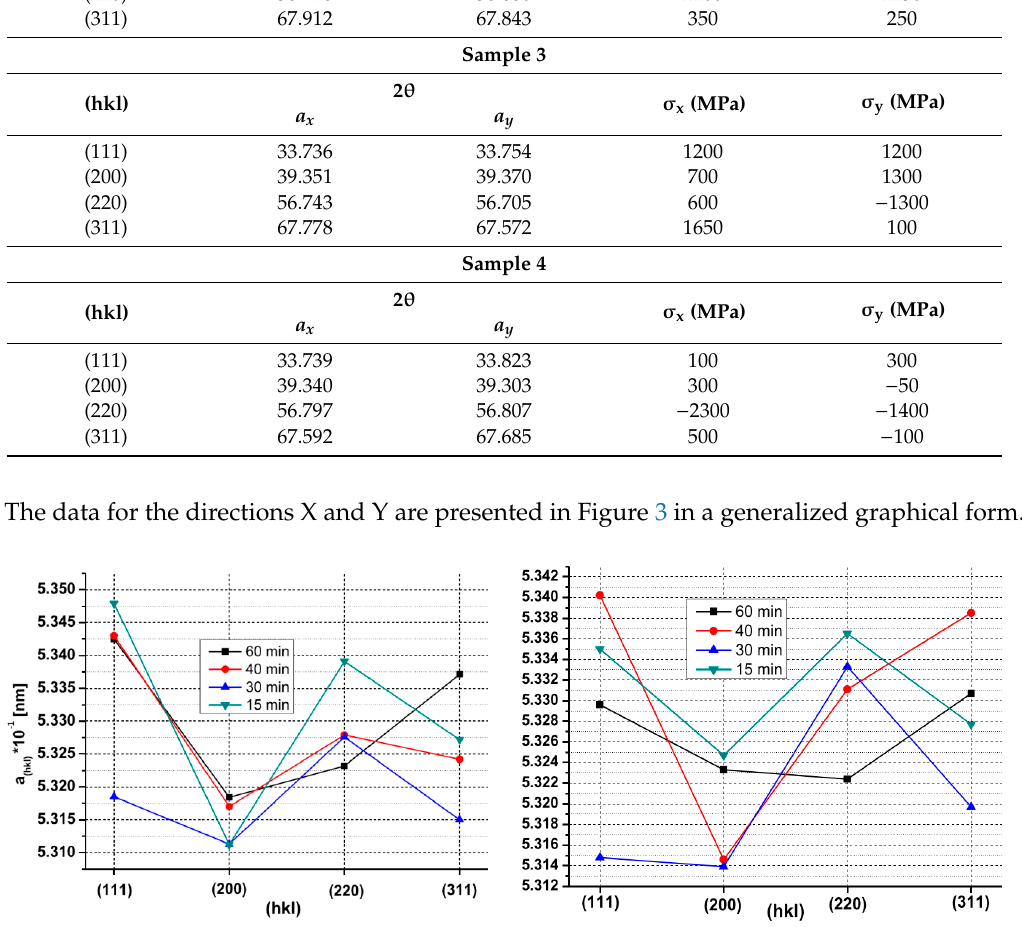
Figure 3. Values of the lattice periods calculated for the reflections characterized by elastic constants and, accordingly, different lattice deformation under the influence of residual stress. ( a ) Direction X, and ( b ) Direction Y.